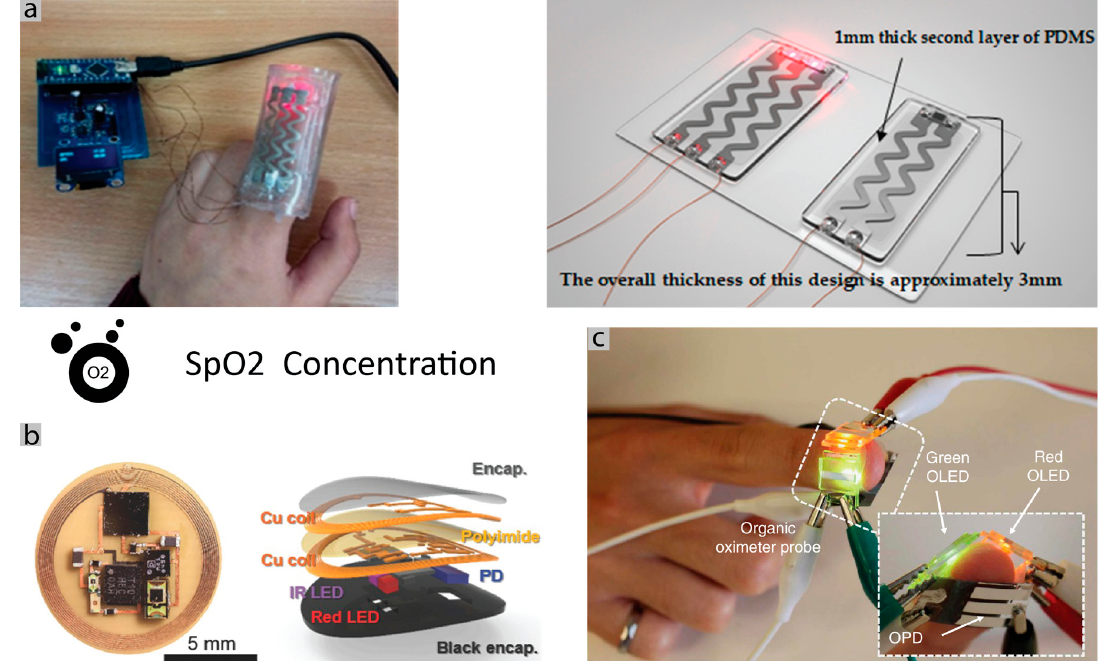
Figure 10. Oximeter sensors. ( a ) Oximeter sensor consisting of printed silver interfaces, on top of flexible PDMS, and connecting the LEDs and PD. It has stretchable possibilities due to geometry. Adapted with permission from [94]. ( b ) Small oximeter with copper traces and coils on top of a polyimide substrate inside a black encapsulation reduces exterior optic interferences. It has NFC communications using energy harvesting from RF waves. Adapted with permission from [46] ( c ) Oximeter made with organic LEDs and organic PD on a plastic substrate in ring shape Adapted with permission from [95].